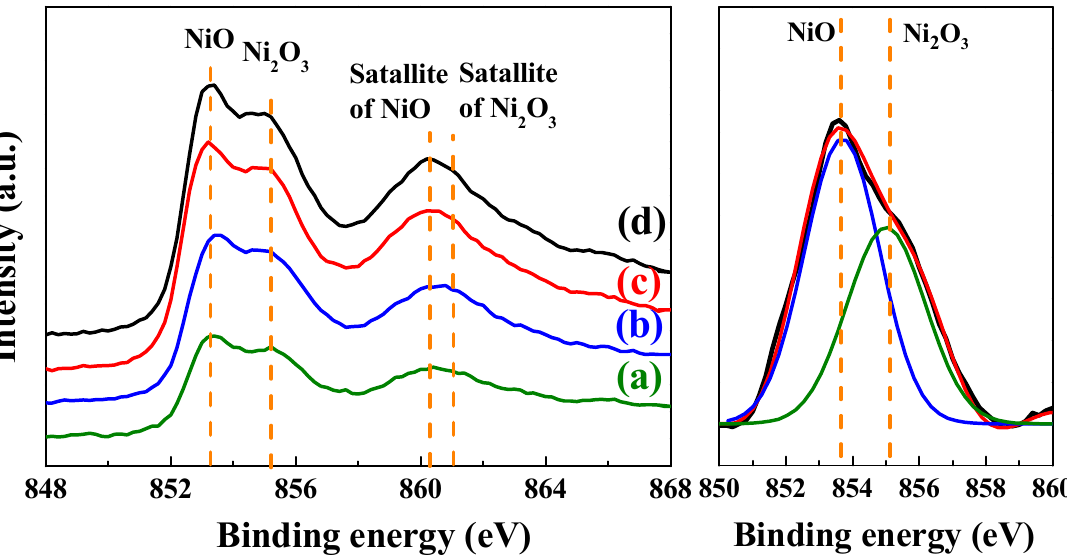
Figure 7. Ni 2p 3 / 2 XPS spectra of the L2NiO thin films as a function of annealing temperatures and times: ( a ) 400 ◦ C for 1 h, ( b ) 400 ◦ C for 3 h, ( c ) 500 ◦ C for 3 h, and ( d ) 600 ◦ C for 3 h.